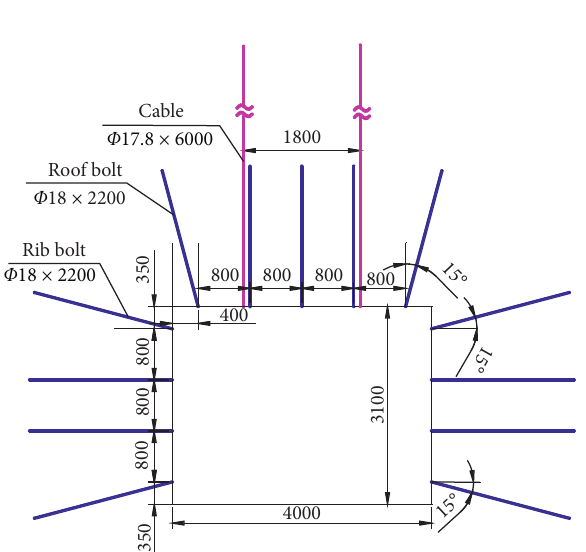
Figure 1: Rock strata and geological description.